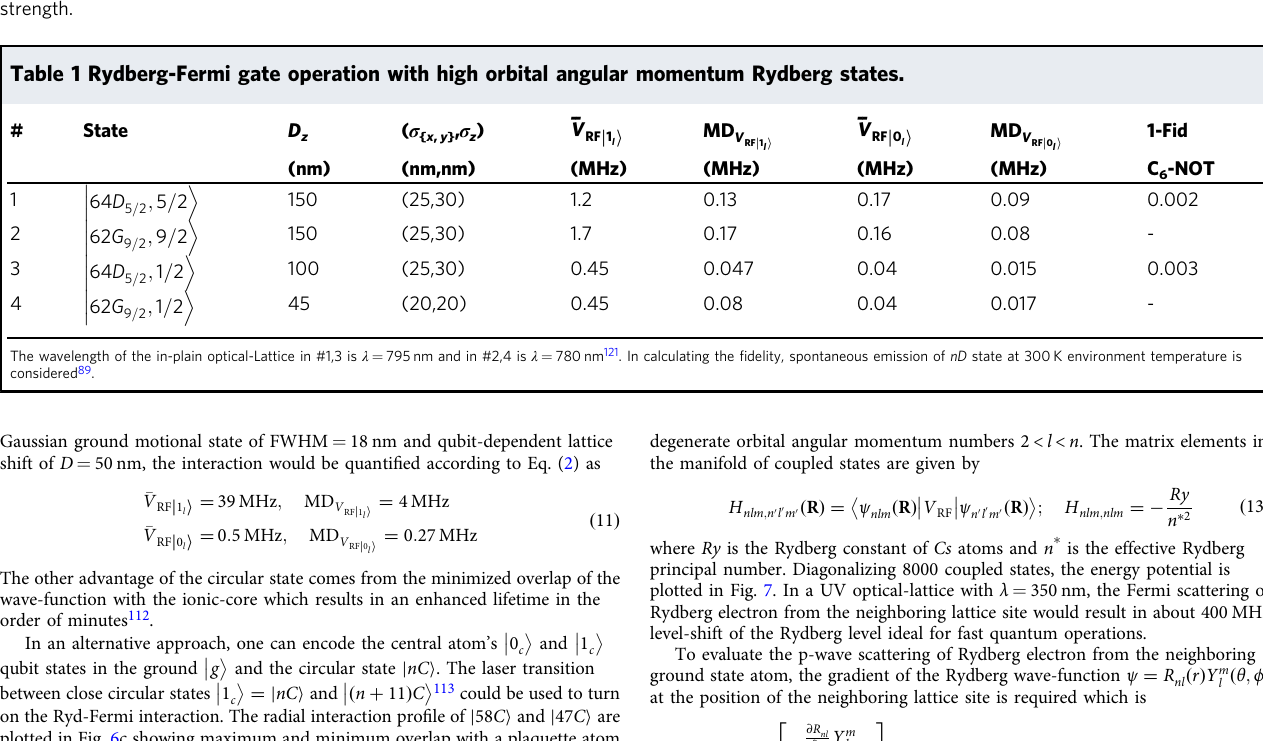
(cid:1) (cid:3) (cid:1)